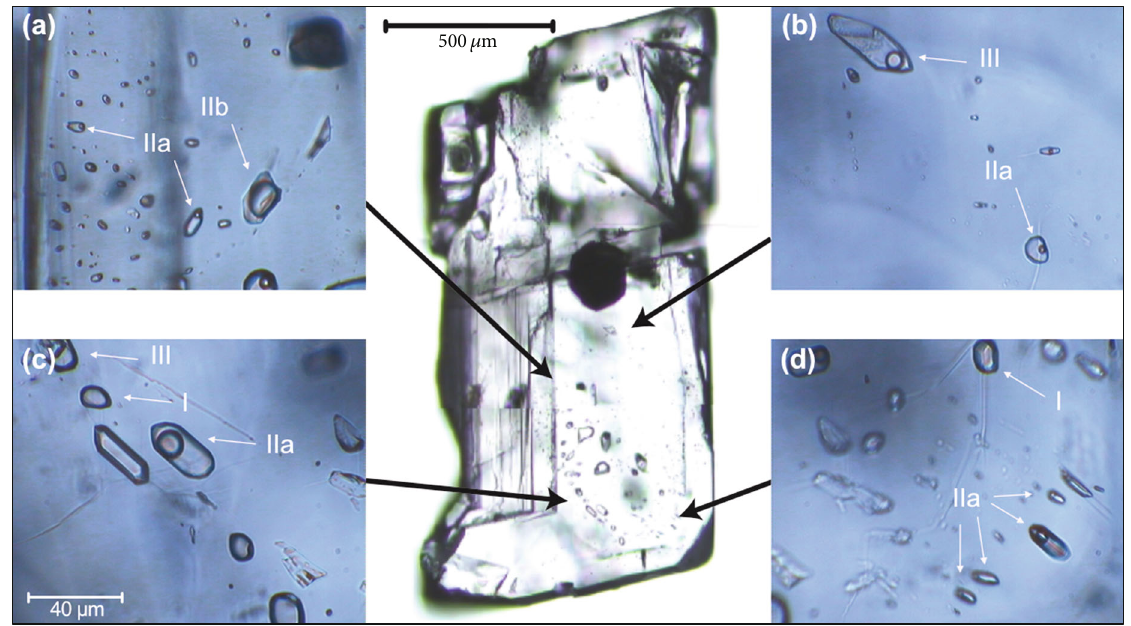
Figure 3: Petrographic relationships for fl uid inclusions in sample SO253-085-6R. The photographs were taken at room temperature and show di ff erent sizes, shapes, and types of inclusions. (a) Typical Type IIa liquid-rich inclusions with a single Type IIb vapor-rich inclusion in a primary trail; (b) small group of primary inclusions with Type IIa (lower right-hand corner) and a Type III daughter-mineral-bearing inclusion (upper left-hand corner); (c, d) two photographs of a prominent primary fl uid inclusion trail following crystal growth faces with Type I - Type III inclusions and varying LV